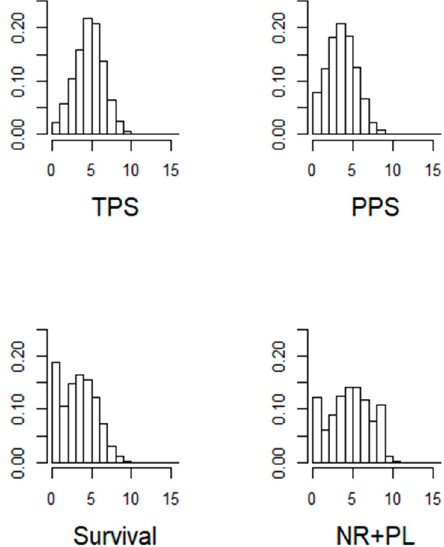
Figure 4. Proportions of the sample plots (total number of plots summarize to 1) with indicated numbers of seedlings, ranging from 0 to max registered value 14 (corresponding to 0–5600 ha − 1 ): TPS, Total number of planted seedlings; PPS, Properly planted seedlings; Survival, Number of planted seedlings after three years; NR + PL, Number of naturally regenerated and planted seedlings after three years.